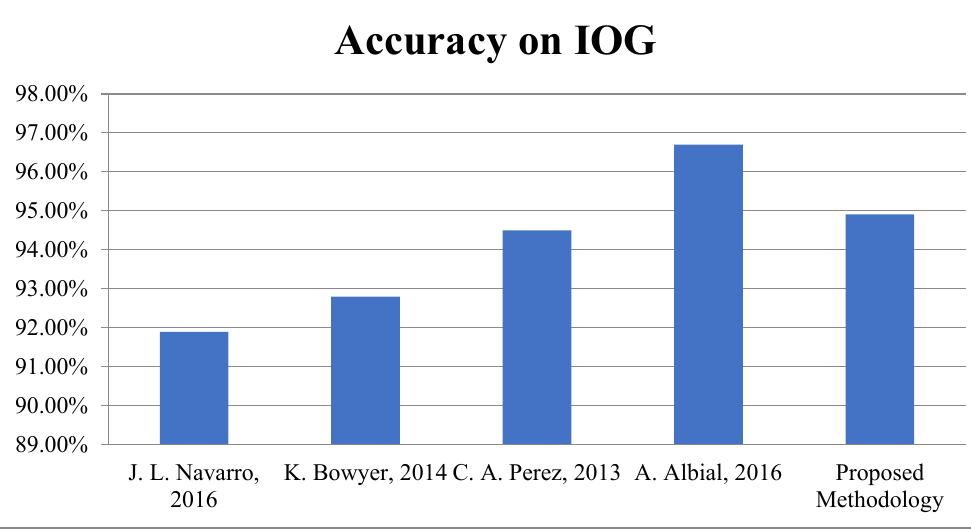
Figure 16. Accuracy Comparison for Gender Classification on